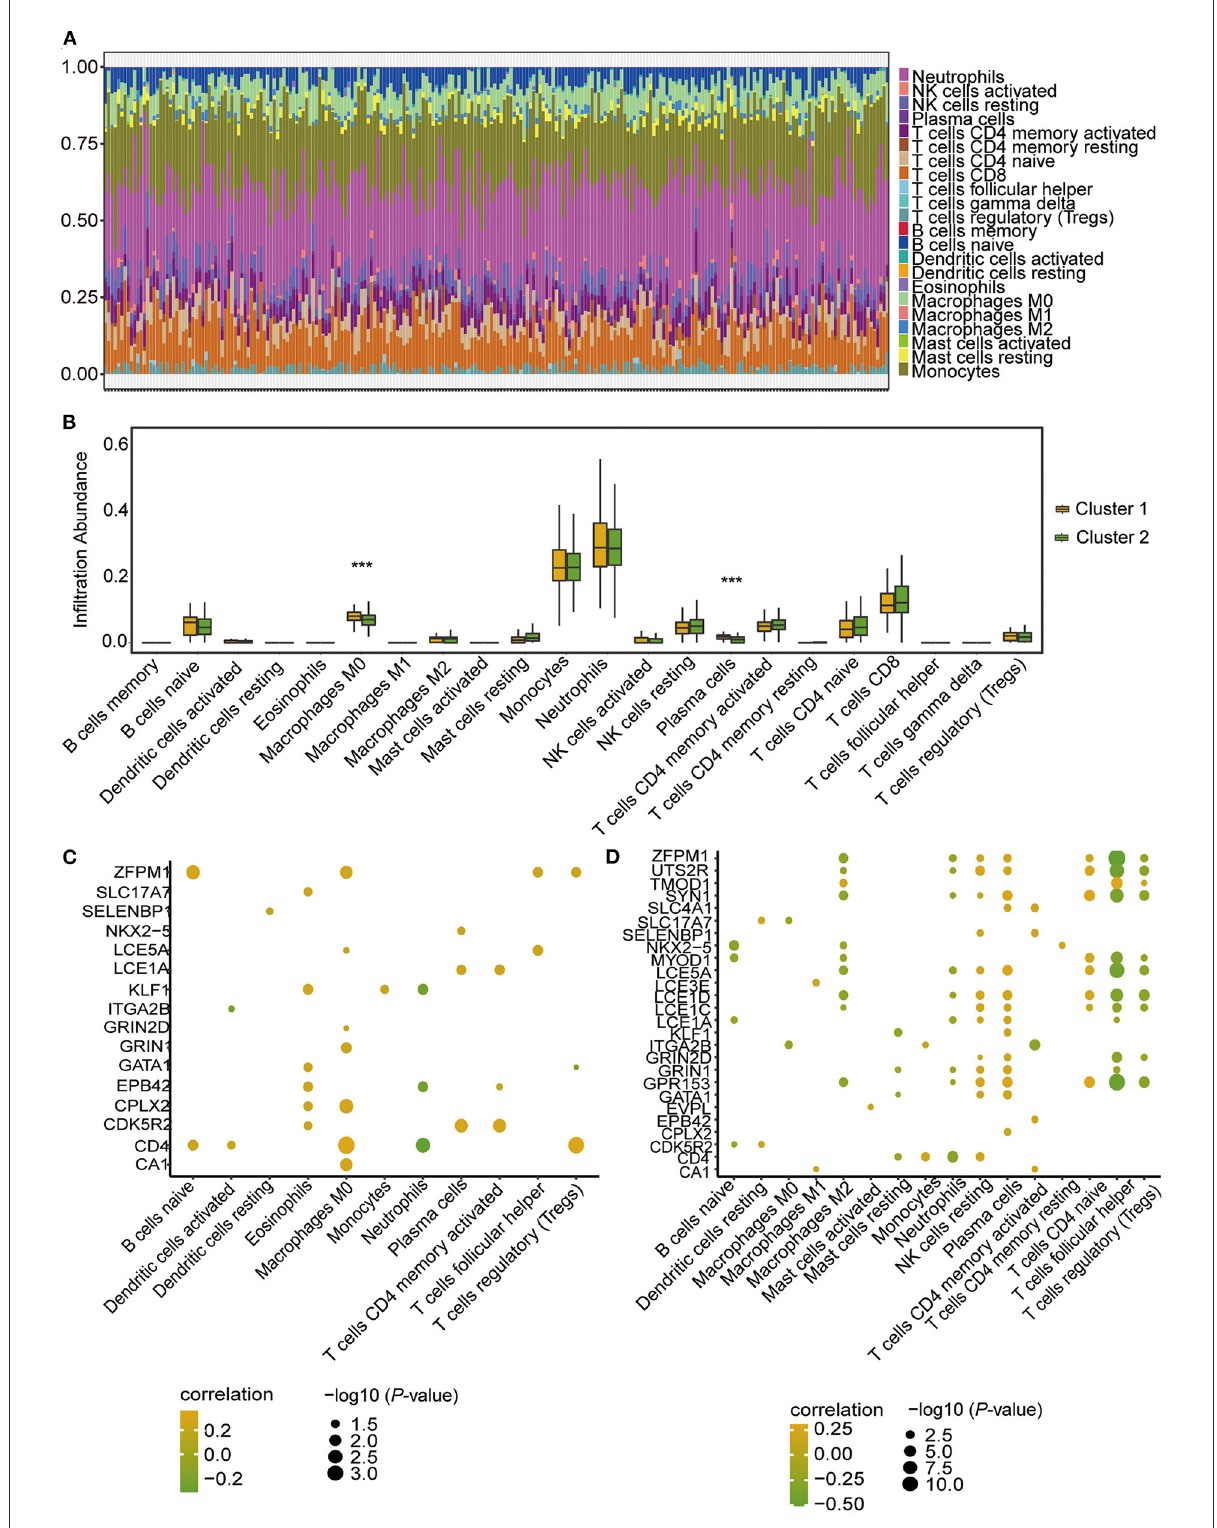
FIGURE9 Infiltrating proportion of immune cells in CHD patients of the two m6A RNA modification patterns according to CIBERSORT algorithm. (A) The landscape of immune cells infiltration in patients with CHD based on CIBERSORT algorithm. (B) Box plot showing the proportion of immune cells infiltration between cluster 1 and cluster 2. The statistical significance was calculated via Wilcoxon rank sum test, *** P < 0.001. (C,D) The correlation between hub-genes and immune cell levels in cluster 1 (C) and cluster 2 (D) . The horizontal axis represents immune cells, the vertical axis represents Hub gene, the node color represents correlation, and the node size represents significance